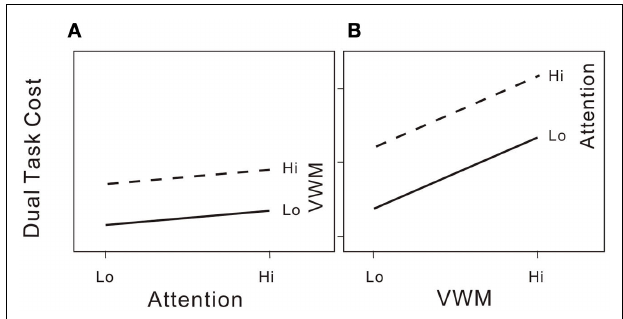
FIGURE 2 | (A) Hypothetical dual-task costs (percentage error) on the attentional task under the 2 × 2 (high/low attentional load × high/lowVWM load) conditions if attention is the sole significant limit onVWM capacity. (B) Dual-task costs (percentage error) on theVWM task under the 2 × 2 (high/low attentional load × high/lowVWM load) conditions if attention is the sole significant limit onVWM